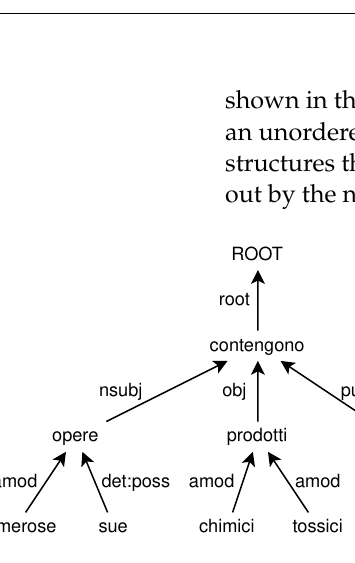
Figure 2. Tree corresponding to the Italian sentence “Numerose sue opere contengono prodotti chimici tossici.” ( “Many of his works contain toxic chemicals.” ), on the left, and two subtrees extracted from the main tree, on the